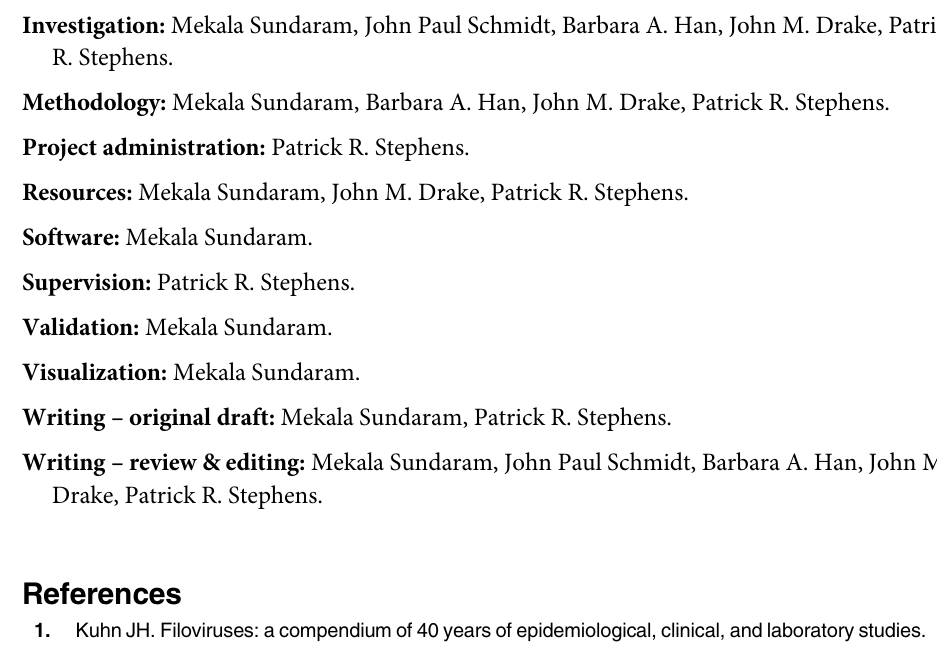
S1 Fig. Plots of significant phylogenetic eigenscores for all mammalian clades. Phylogenetic eigenvector 3 or c3 plotted on maximum clade credibility tree (A), phylogenetic eigenvector 11 or c11 plotted on maximum clade credibility tree (B), and phylogenetic eigenvector 12 or c12 plotted on maximum clade credibility tree (C). These eigen scores consistently predict host mortality and host infection status; with c3 positively being related to host status, c11 and c12 being negatively related to host status. S2 Fig. Predictions of reservoir status for all known terrestrial African mammals and accompanying accuracy metrics. (A) Predictions of reservoir status which are based on ridge model predicting mortality of species after exposure to Ebolavirus and ridge model predicting infection status of species. Ridge models used trait and phylogenetic eigenvectors as predictors (see main text for more details of models). (B) Accuracy of infection status predictions by mammal clade. Silhouettes used are available under Public Domain (https://creativecommons.